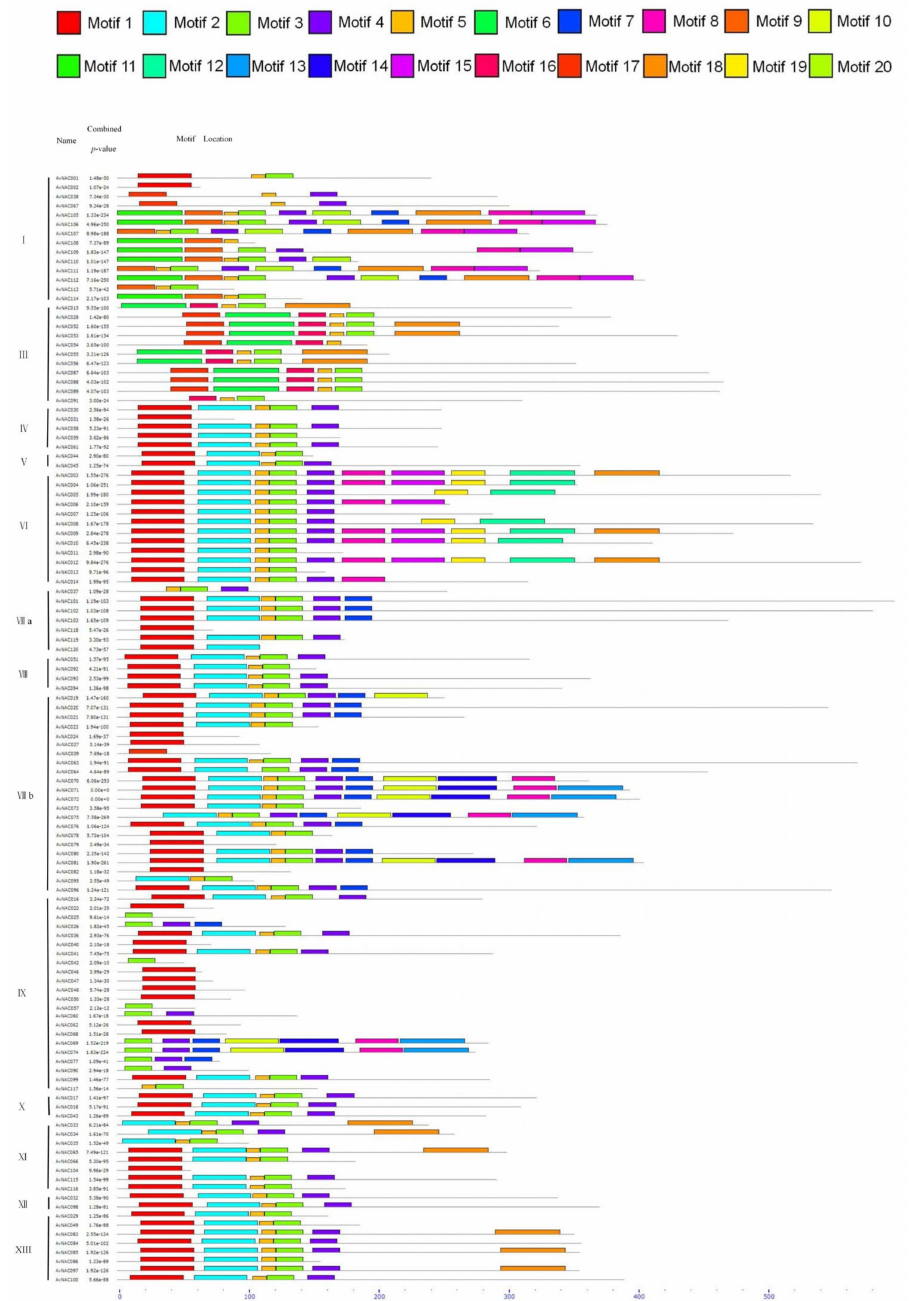
Figure 2. The conservative motif analysis of the NAC family in kiwifruit. The rectangles of different colors represent different conservative motifs, and black lines represent the non-conserved